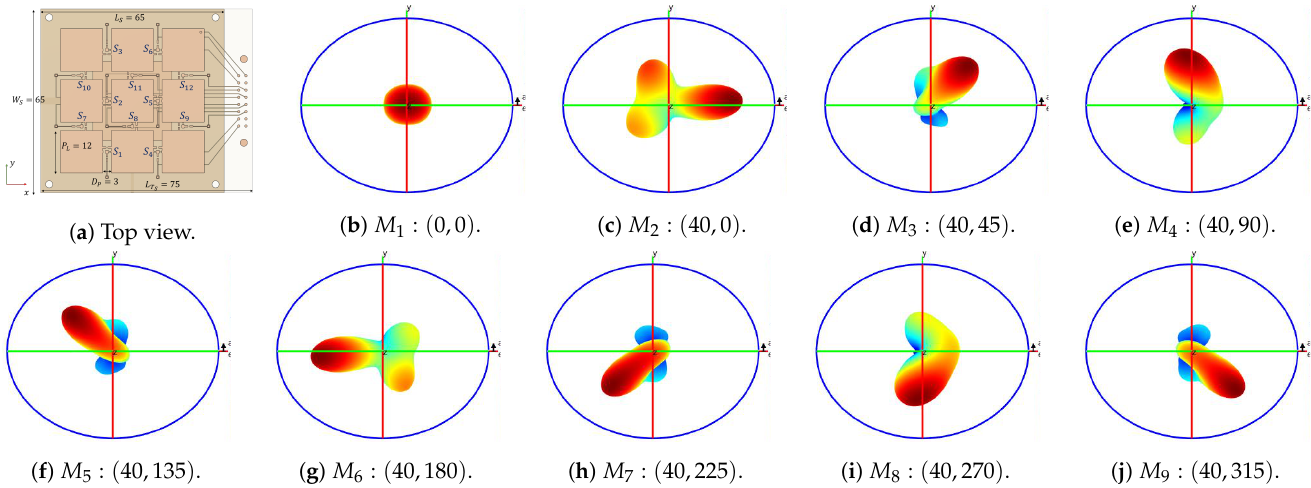
Figure 15. Radiation diagrams at Port 1, for operating mode M i , ( i ∈ 1 . . . 9 ) , pointing towards ( θ 0 , φ 0 ) .